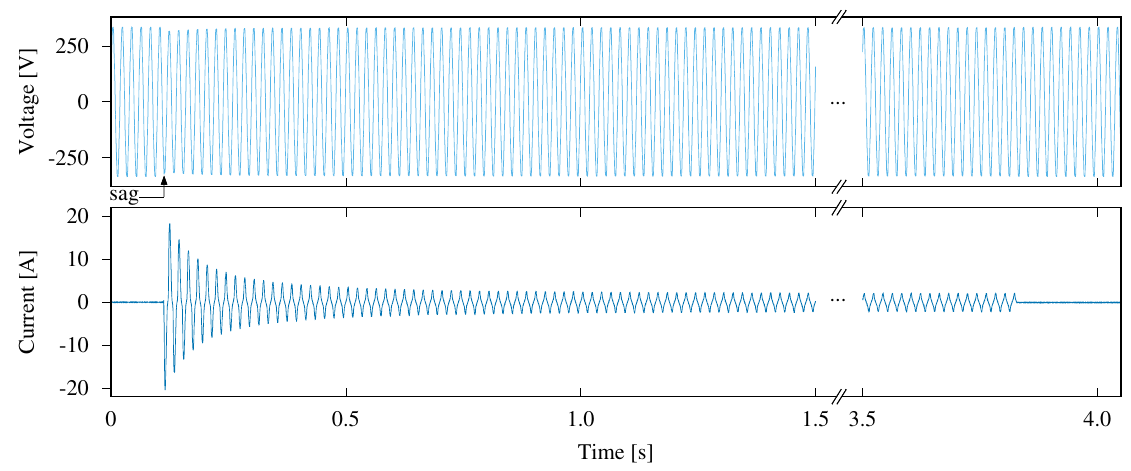
Figure 1. Visualization of voltage and current traces when an electric saw is